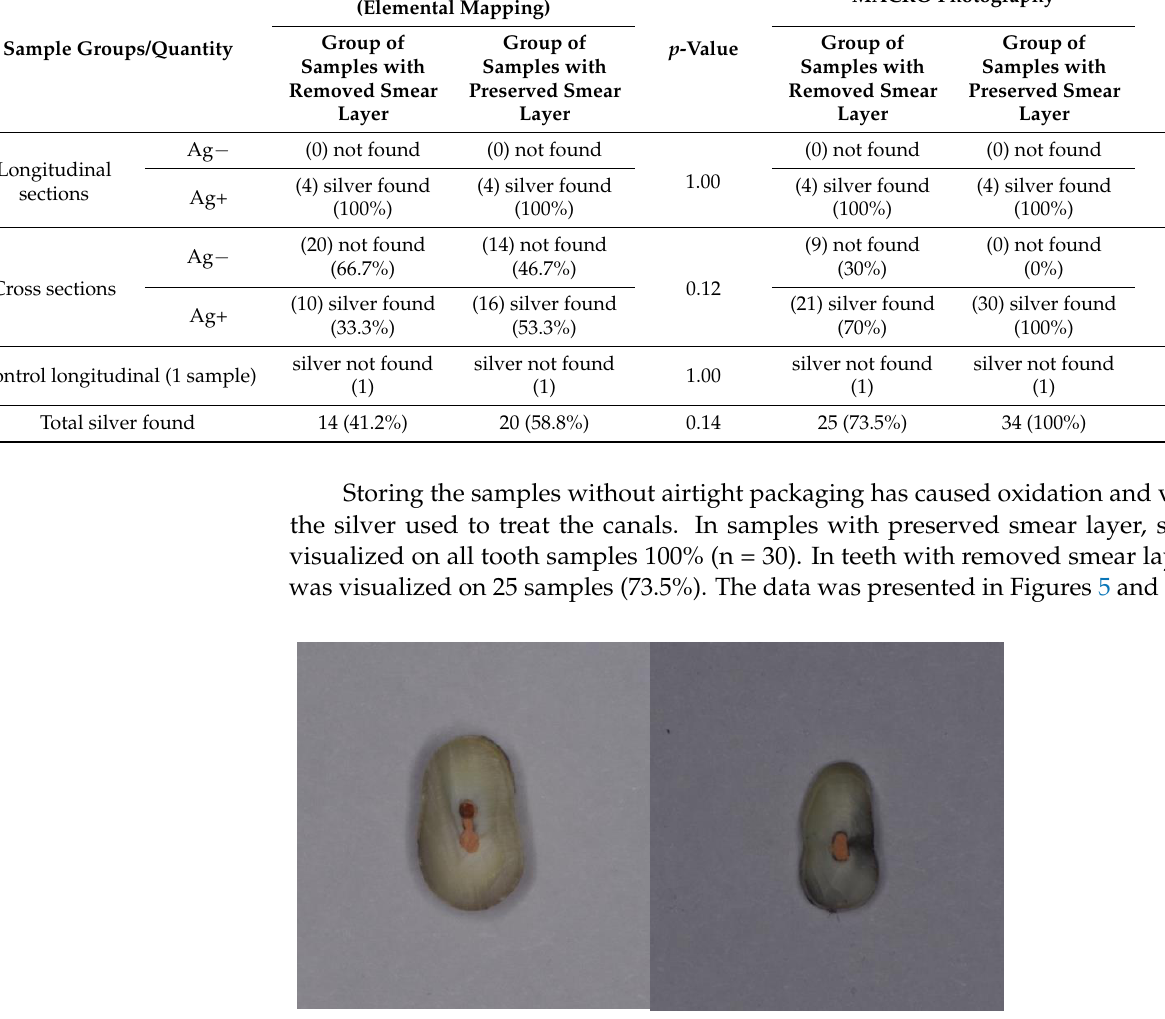
Figure 5. samples with preserved smear layer. Figure 5. Samples with preserved smear layer.